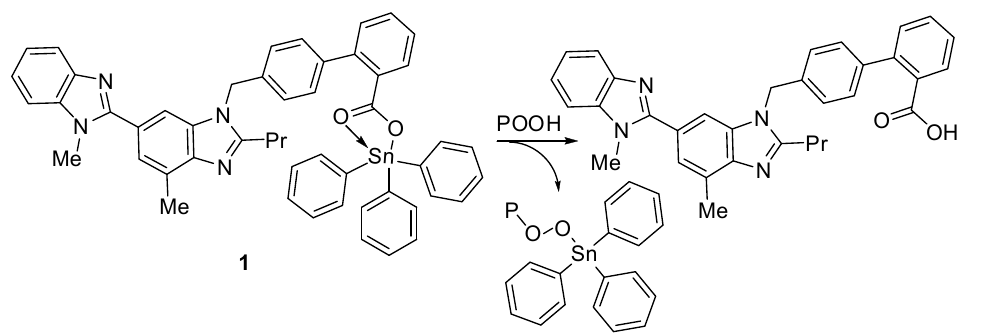
Figure 14. Organotin 1 acts as a hydrogen chloride scavenger.